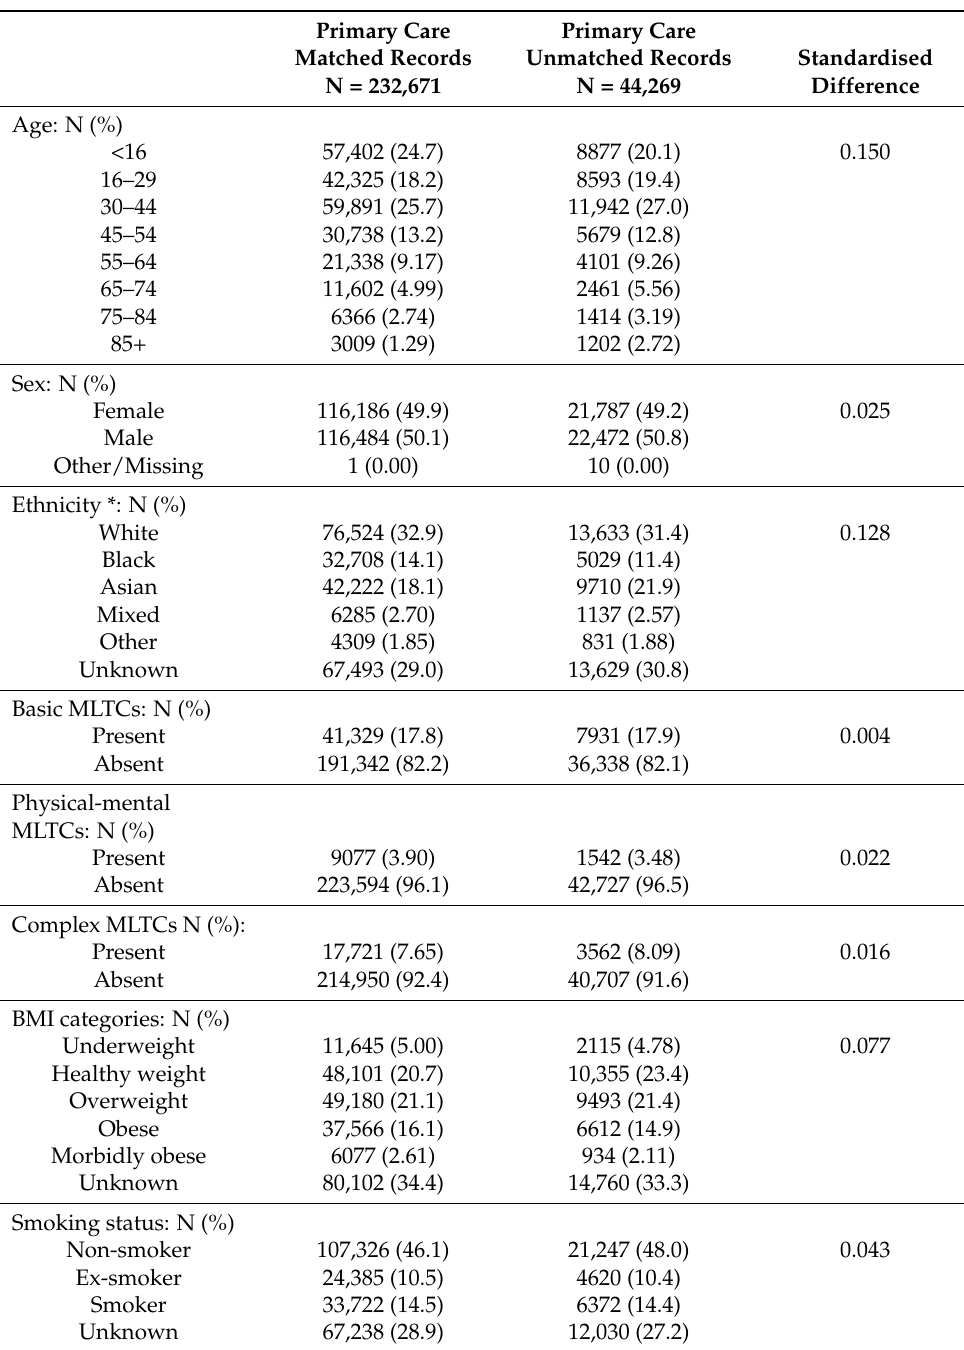
Table A1. Results of analyses to assess potential biases in the linkage results for matched (N = 232,671) and unmatched (N = 44,269) primary care